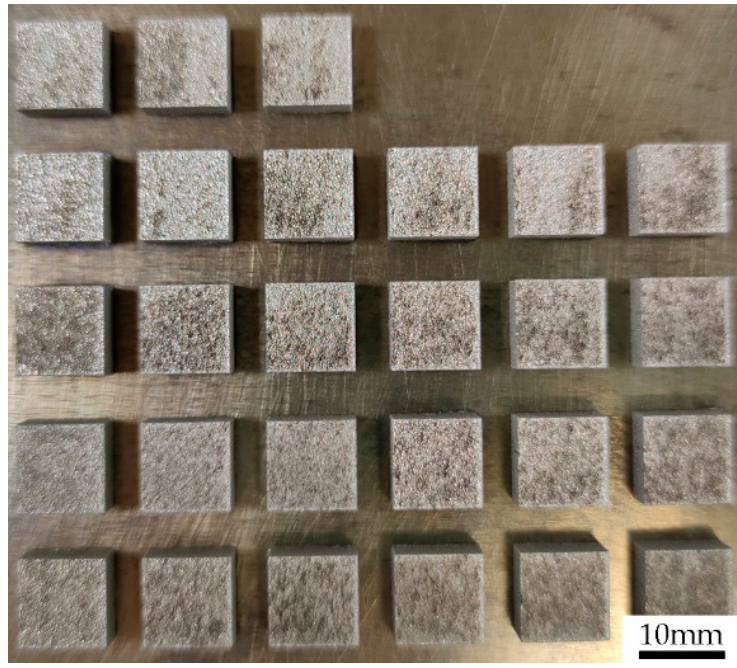
Figure 2. LPBF-processed tungsten samples.